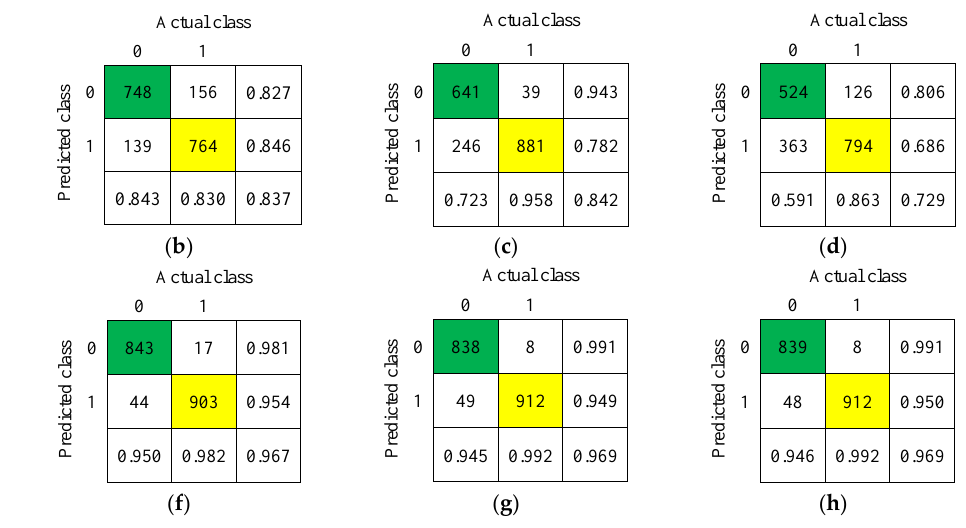
Figure 7. Confusion matrix of test set, where green and yellow represent the number of correctly classified samples with labels of 0 and 1, respectively. ( a ) VGG19–frozen; ( b ) ResNet50–frozen; ( c )